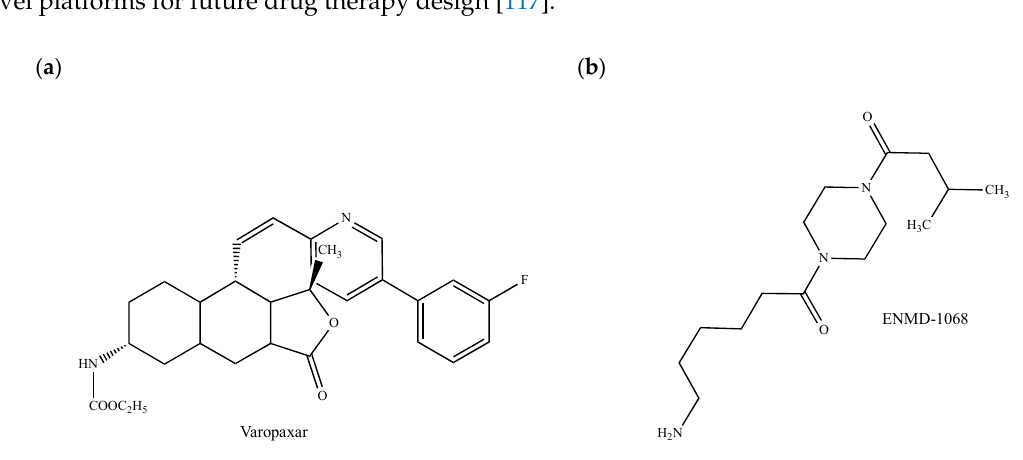
Figure 4. Structure of ( a ) PAR1 and ( b ) PAR4 antagonists.